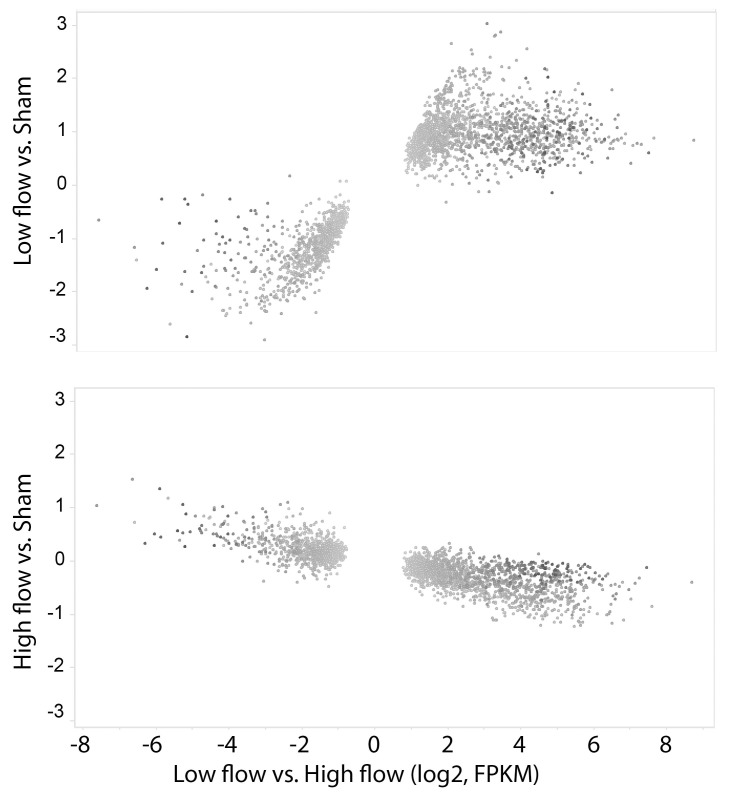
Gene expression changes between low-flow and high-flow intima are mainly due to low flow.Alterations in transcript level for the 2535 genes with p-values<0.0001 in the comparison of low versus high flow. Most of the changes seen in the low vs high flow comparison (X-axis) were stronger in the low vs sham comparison than in the high vs sham comparison (Y-axis). All changes are shown as log2-fold.